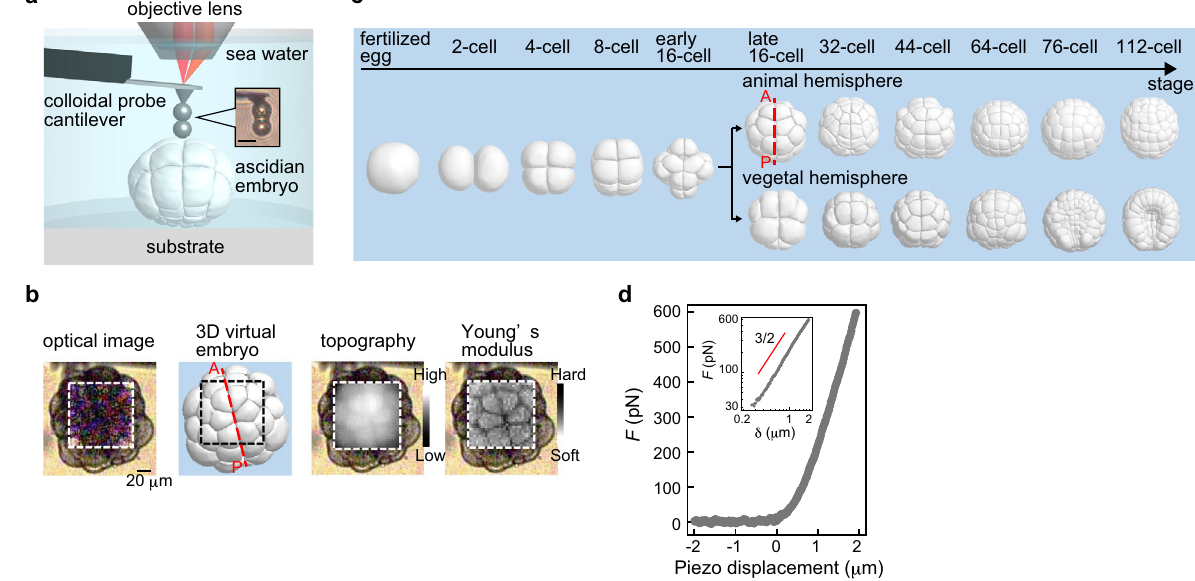
Fig. 1 AFM force mapping measurement of the early developing embryo. a Schematic of AFM for measurement of the developing ascidian embryo weakly adhered on a dish in seawater. The inset shows an optical microscopic image of the customised colloidal probe cantilever arranging two silica beads from the AFM tip with epoxy glue. Scale bar, 10 μ m. b Example of a bright- fi eld optical microscopic image and AFM topographic, i.e., relative height H , and apparent Young ’ s modulus E , images of the ascidian embryo at around the 32-cell stage. The measured embryonic cells and cell lineage were identi fi ed by comparing the AFM images with a 3D model 52 . The values of soft and hard presented here are ν = 1.4 and 2.8 of ν = log 10 E (Pa), respectively. c Morphological change in the 3D ascidian embryo model at early developmental stages from the fertilised egg to the 112-cell stage before gastrulation, measured by AFM. Dotted line (red) represents the anterior – posterior line of the embryo. d Typical AFM force – distance curve measured in an upper region of a developing embryo sample. As shown in the inset, the force-indentation curve within 2 μ m of the indentation depth δ followed the power law of 3/2, which corresponds to both conventional and modi fi ed Hertzian contact models ( ‘ Methods ’